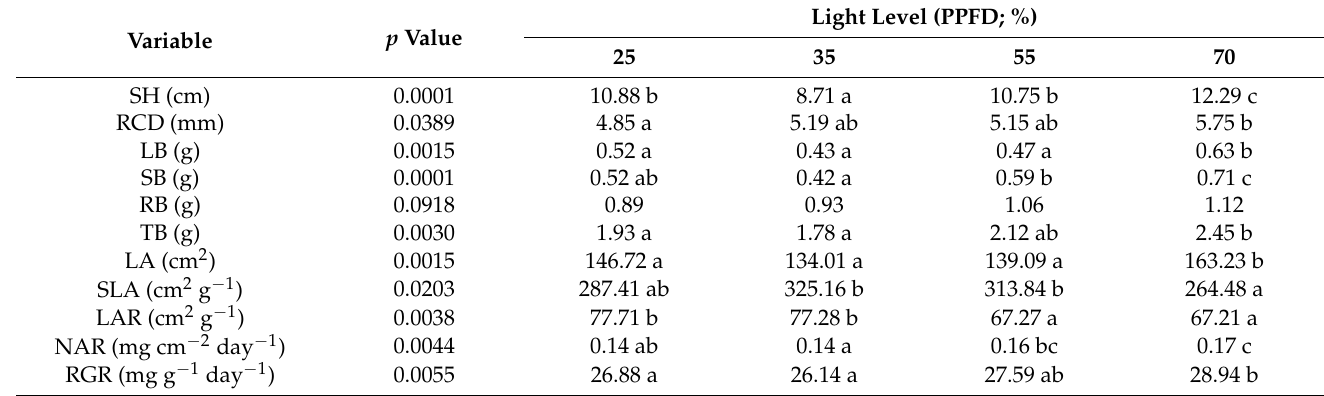
Table 1. Statistical significance and averages ( n = 12) in morphology variables, net assimilation rate and growth of Crescentia alata plants exposed to varying light levels in relation to photosynthetic photon flux density (PPFD). For the same variable, means with letters in common are not significantly different ( p > 0.05) according to Fisher’s LSD test ( α = 0.05). SH, shoot height; RCD,